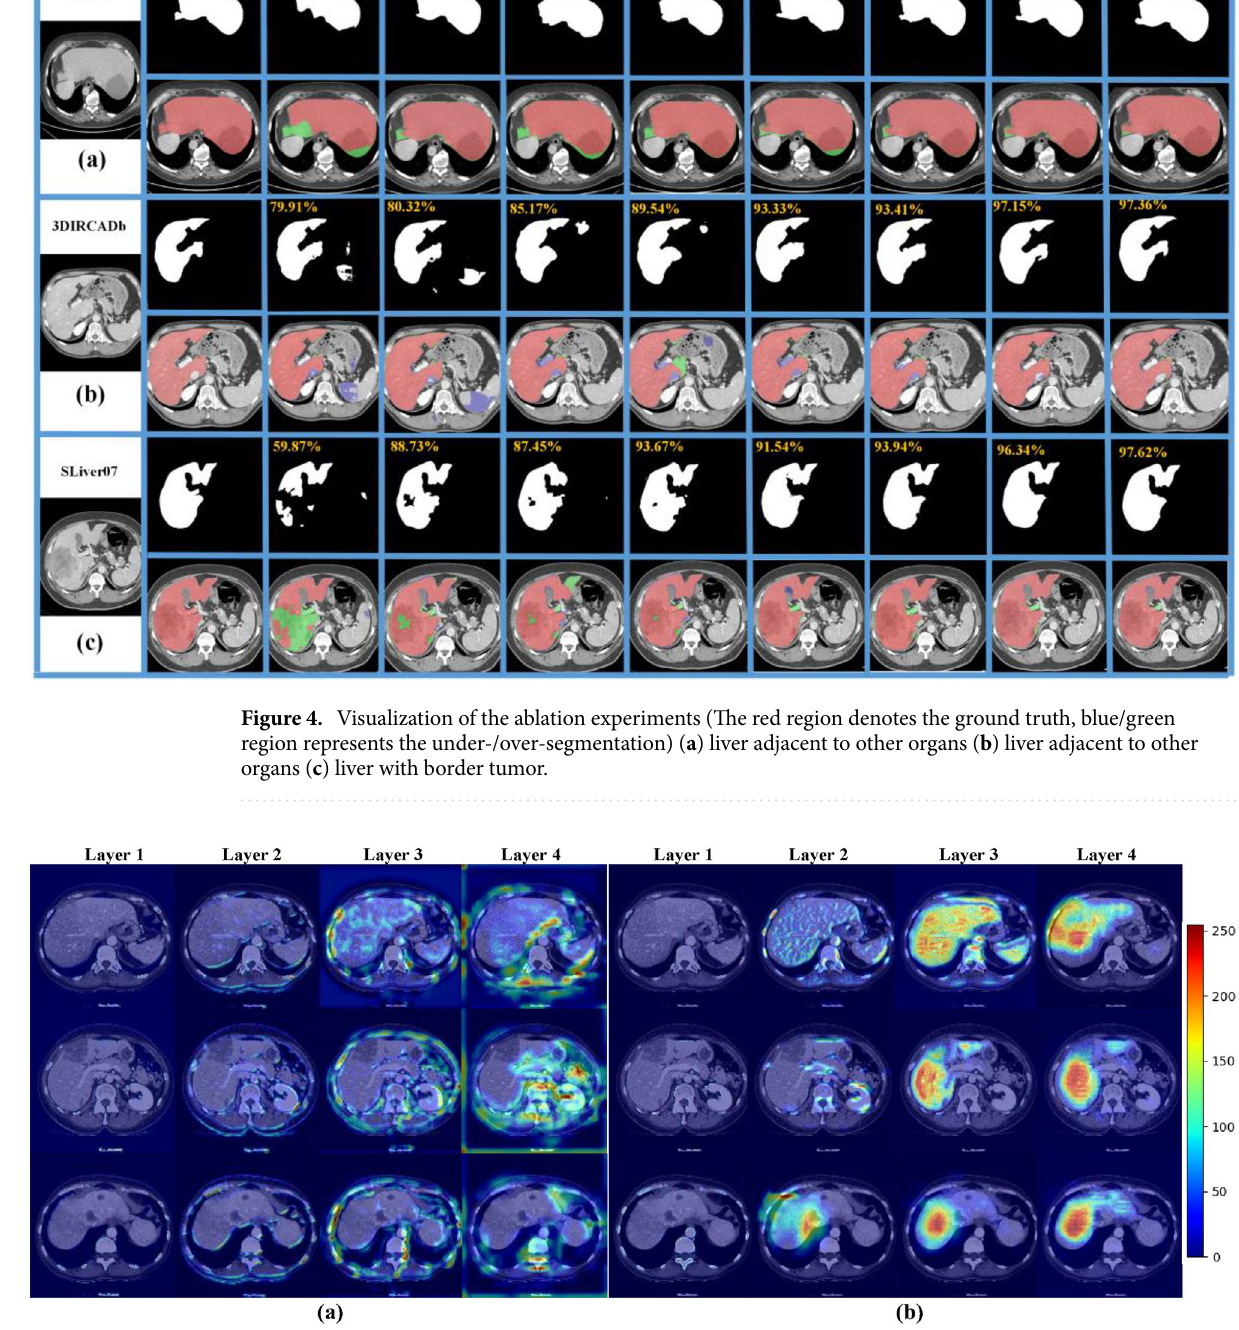
Figure 5. Heat maps obtained from different feature layers with and without DSM from layers 1–4. ( a ) without DSM ( b ) with